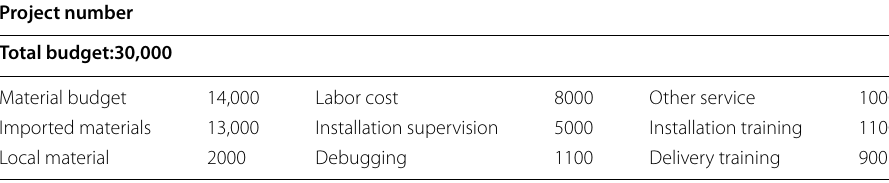
Table.1 Relationship between project budget and annual budget Project